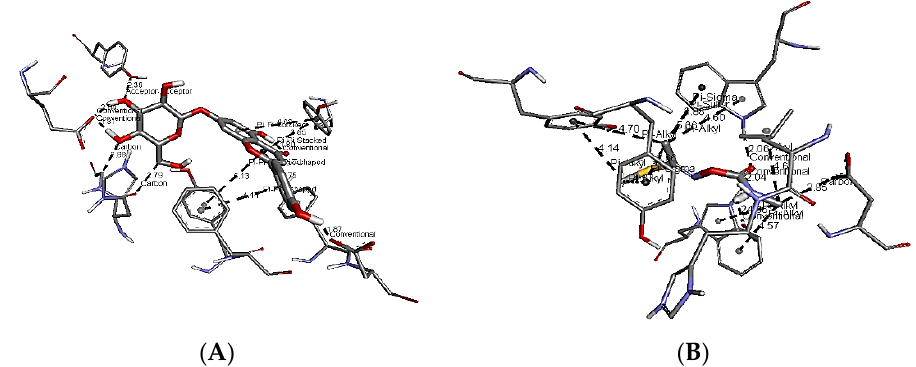
Figure 8. Types and distances of interactions between AChE and ( A ) apigenin 7-glucoside or ( B ) control (lannate).